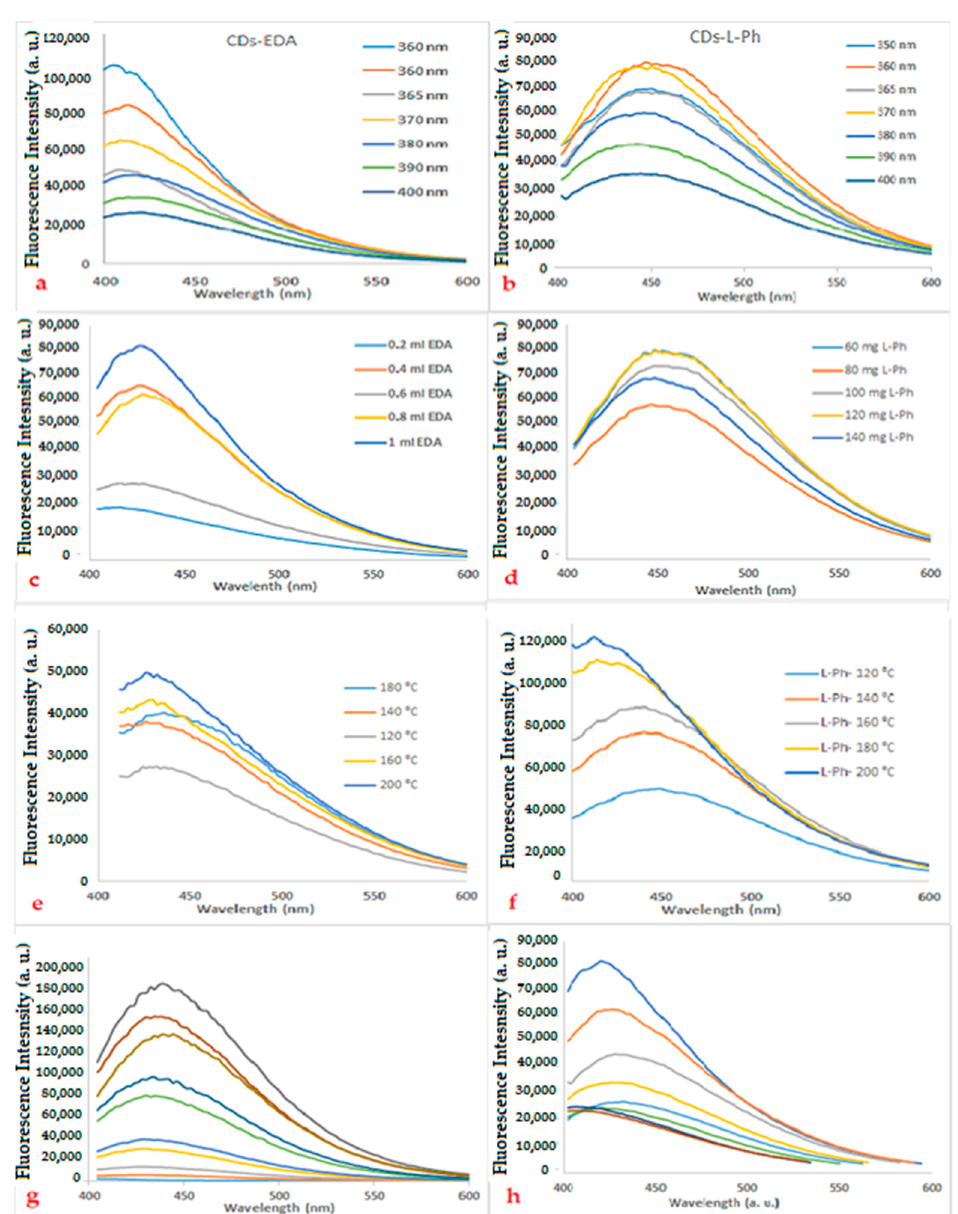
Figure 4. PL emission spectra of ( a ) CDs-EDA ( b ) CDs-L-Ph, at an excitation wavelength range of 350–400 nm; ( c ) effect of Volume of EDA on Emission spectra of CDs-EDA ( d ) effect of Mass of L-Ph on Emission spectra of CDs-L-Ph; ( e ) effect of temperature on the emission spectra of ( e ) CDs-EDA ( f ) CDs-L-Ph. Effect of dilution on the emission spectra of ( g ) CDs-EDA ( h ) CDs-L-Ph.